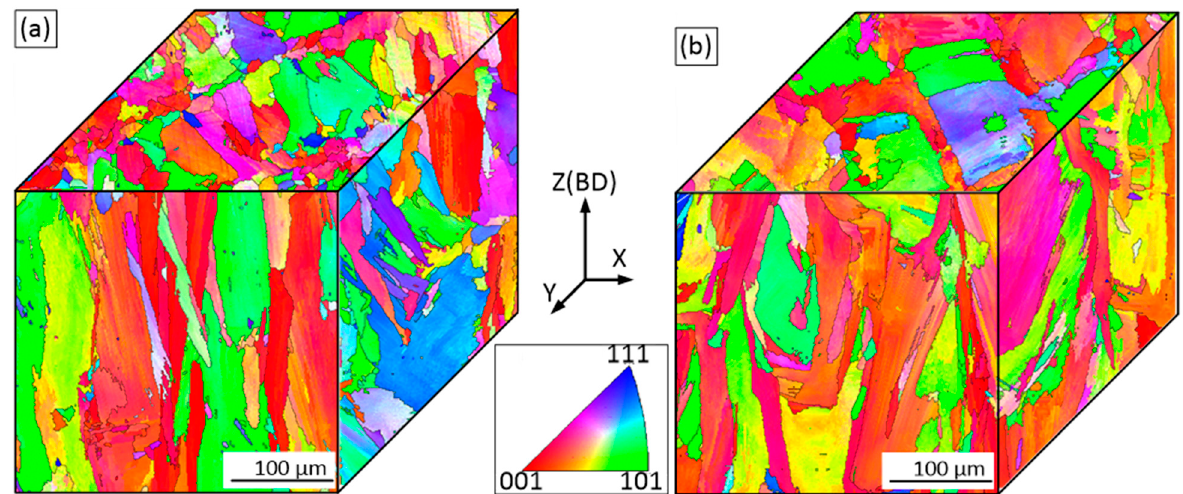
Figure 6. Orientation image microscopy (OIM) maps for the ZX and XY planes of the as-built ( a ) Alloy 1 and ( b ) Alloy 2.